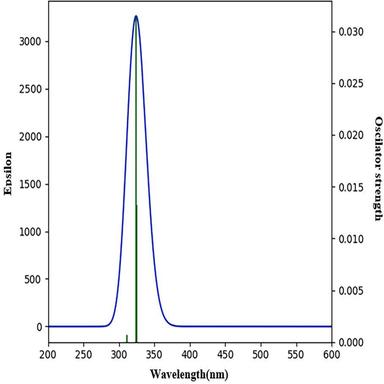
Simulated UV–Visible spectrum of (C8H12N)42.